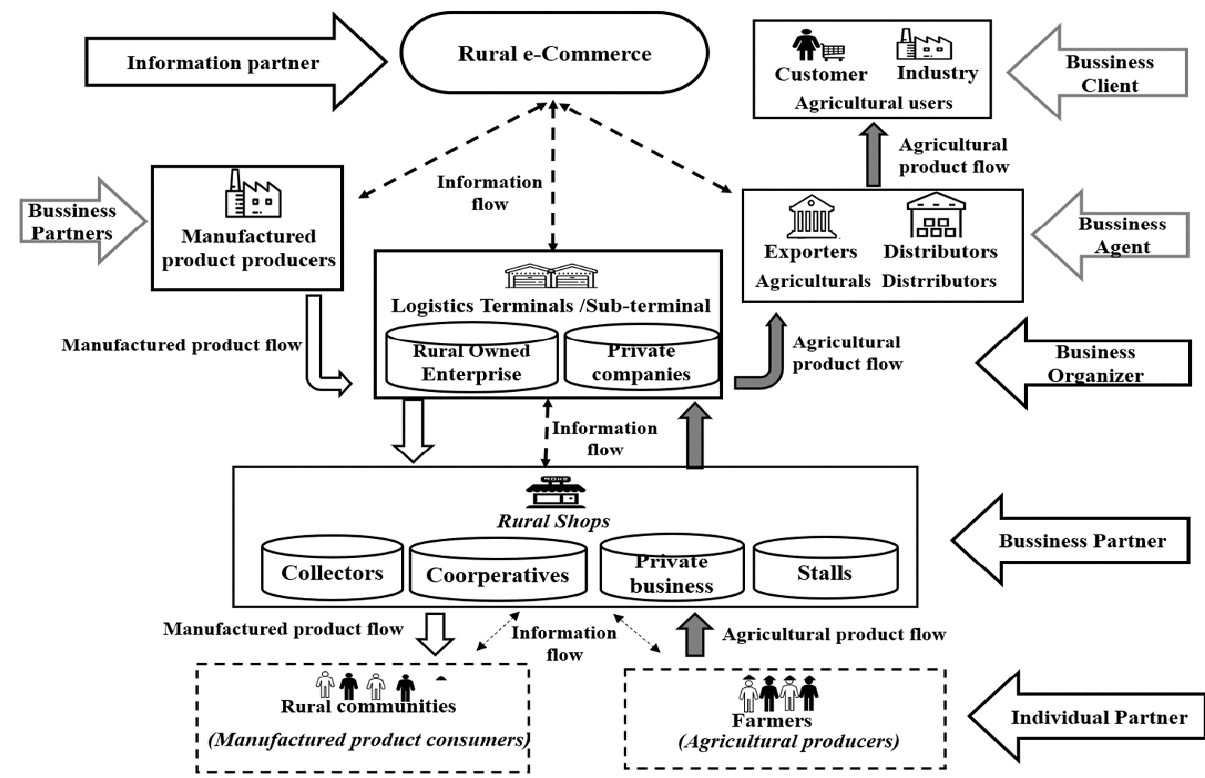
Figure 2. The actors of trade logistics network for rural logistics system